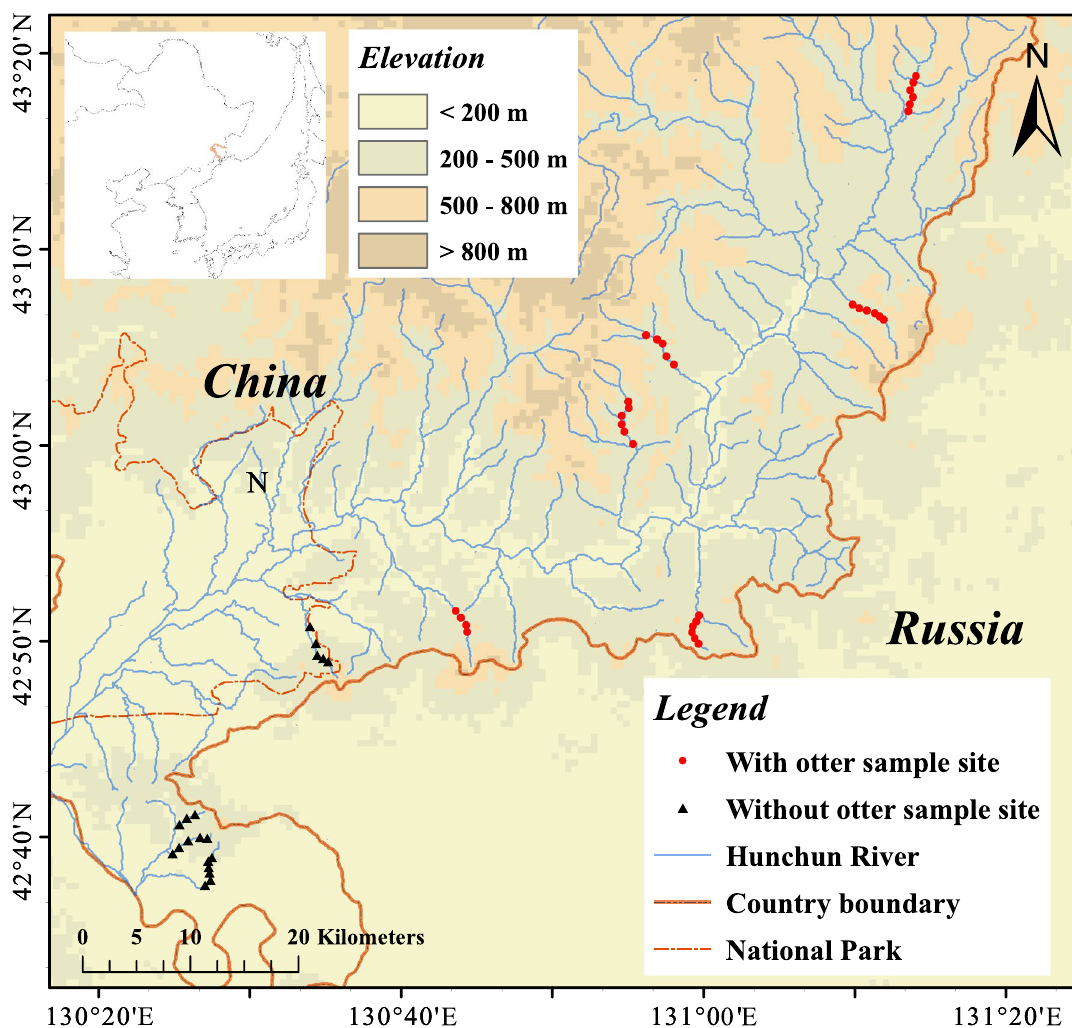
Figure 1. Location of study area within the Hunchun River Basin (HRB), Jilin Province, China. The red circle and black triangle points represented the presence and absence of L. lutra , respectively. Map was created